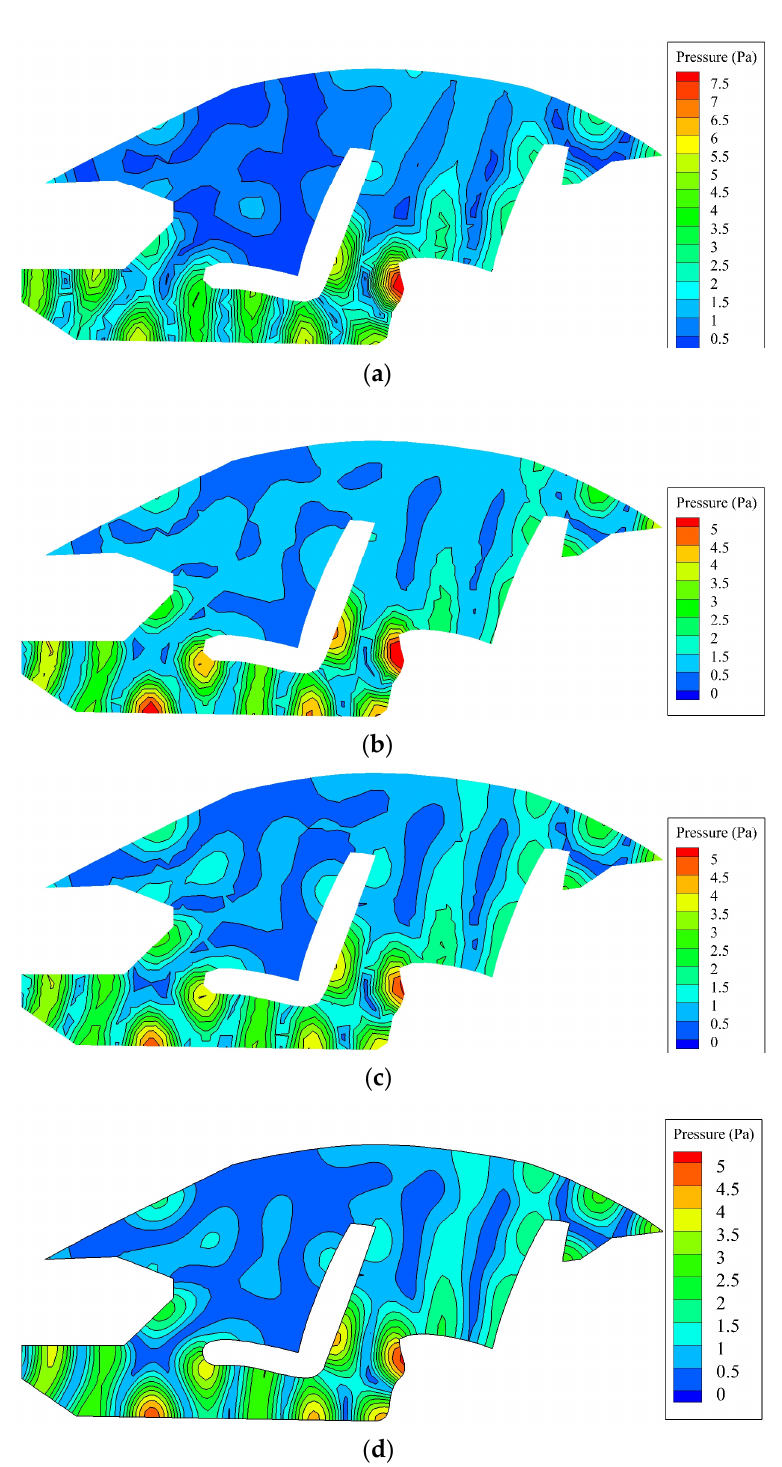
Figure 14. Comparisons the calculated acoustic pressure distribution results from di ff erent methods in the total problem domain for the frequency value f = 320 Hz: ( a ) FEM-T3; ( b ) EFEM-N9; ( c ) EFEM- N11; ( d ) reference solution.